Question: Author a descriptive caption for the visualization shown.
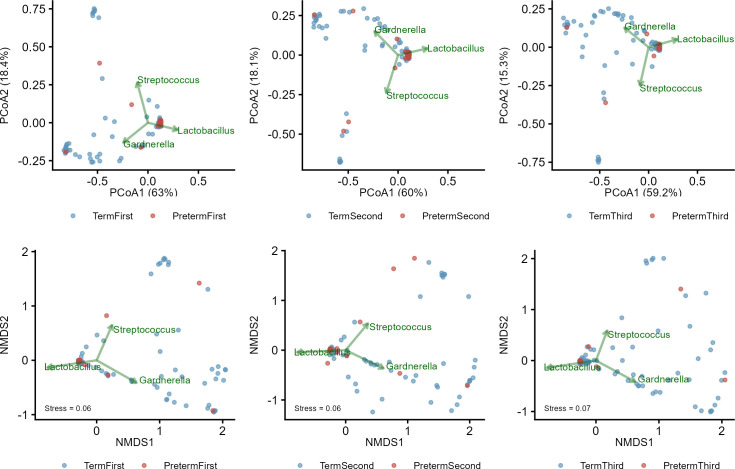
Answer: Beta diversity analysis (Bray-Curtis). PCoA and NMDS plots per trimester showing term (blue) and sPTB (red) samples. Sample sizes: first (term n = 235, sPTB n = 21), second (term n = 246, sPTB n = 24), third (term n = 243, sPTB n = 10). Variance explained in parentheses. ANOSIM R statistics with 95% CI: first ( P = 0.387, q = 0.536), second ( P = 0.117, q = 0.351), third ( P = 0.059, q = 0.315) were not significant. Three clusters driven by (1) Lactobacillus dominance, (2) Gardnerella dominance, (3) Streptococcus /other. Distribution of term/sPTB across clusters did not differ (ANOSIM P > 0.05; Table 2 ).